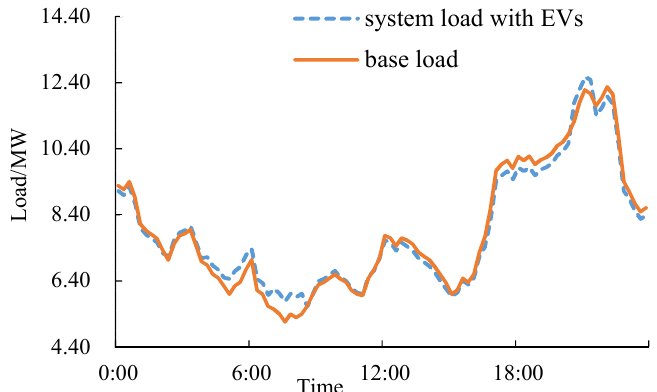
Figure 10. Comparison of load profile between base loads and loads with EVs taken into account.